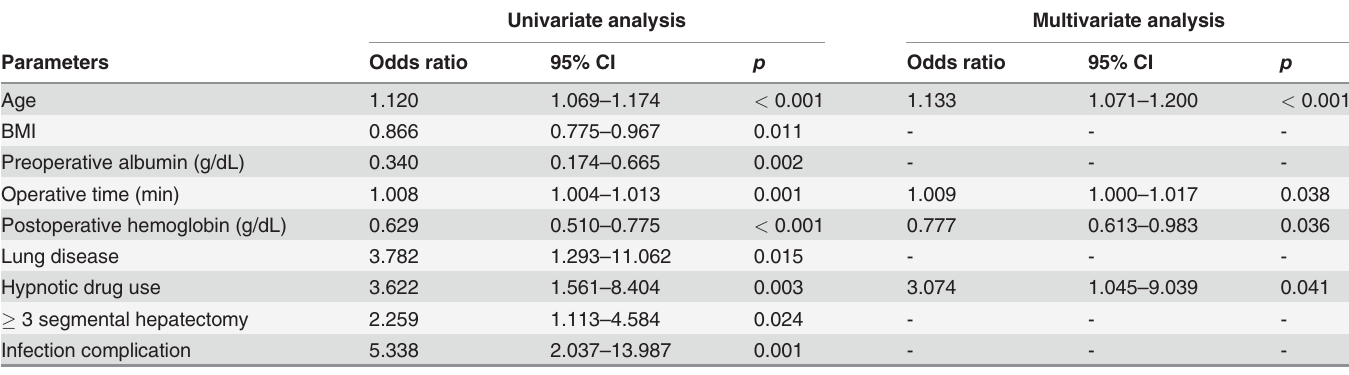
Table 4. Risk factors for postoperative delirium by univariate analysis and multivariate